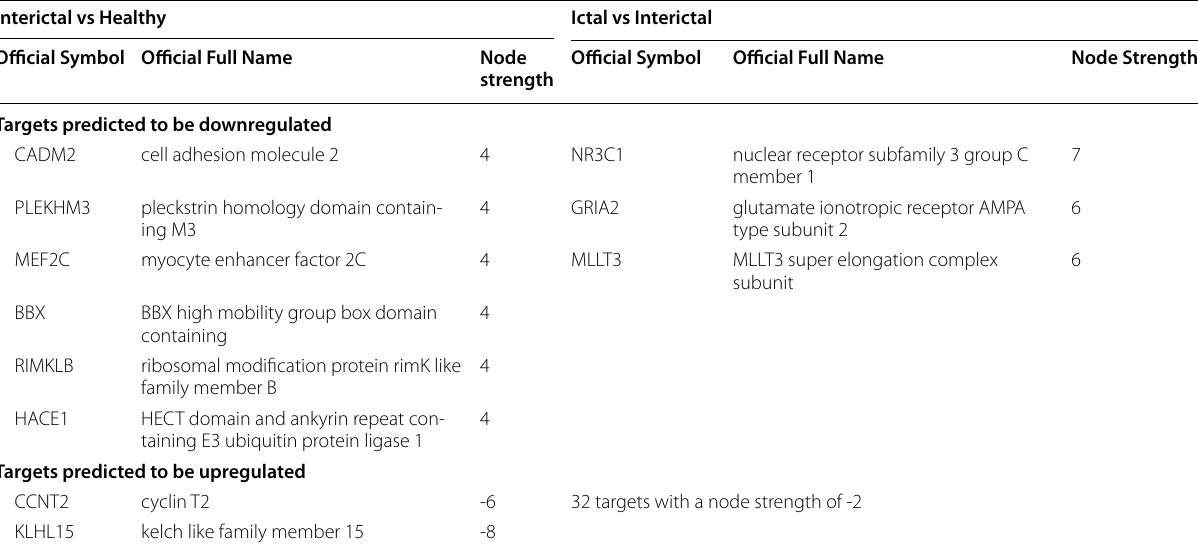
Table 6 List of predicted targets up- or downregulated by DE miRNAs in interictal vs healthy and ictal vs interictal comparison, with the highest absolute node strength values. The intersect of predicted targets and DE mRNAs is available in Table S4-6 Interictal vs Healthy